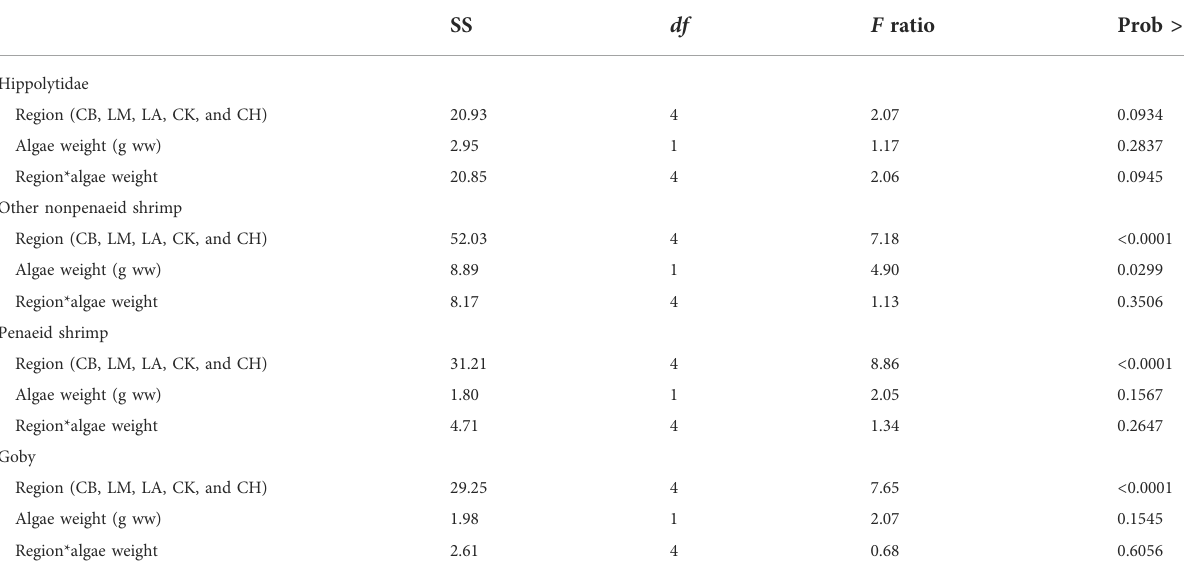
TABLE 2 Selected species-speci fi cabundance comparisons across region and algae weight when seagrass metrics were held constant. Only samples with greater than 75% turtle grass cover and canopy heights of 200 – 400 mm were used in this